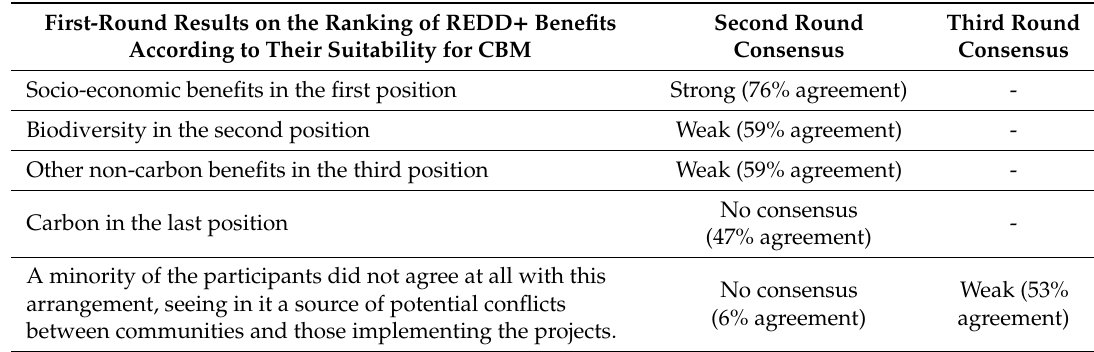
Table 5. Delphi panel results on the suitability of di ff erent REDD + benefits for CBM of REDD + projects in the